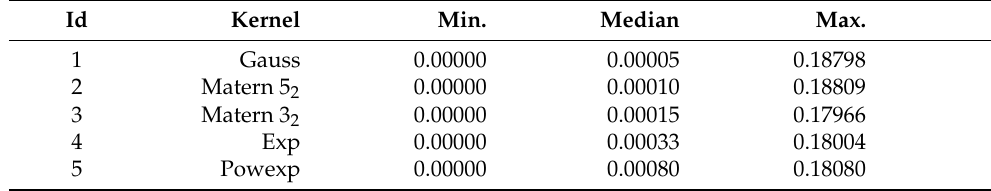
Table 4. Error statistics of the b I meta-model using a distinct Kriging covariance kernel structure. Id Kernel